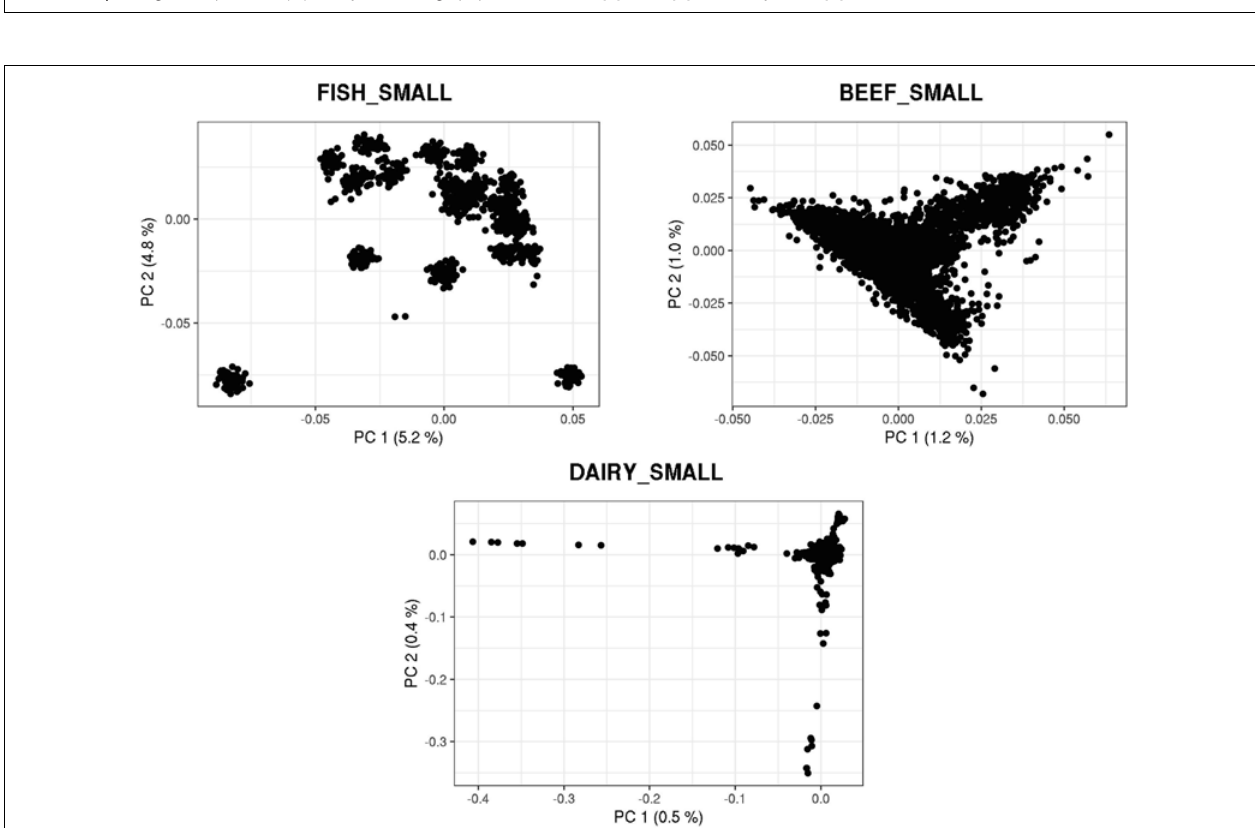
FIGURE 3 | First and second principal components of the genomic relationship matrices for the small populations of fish, beef, and dairy cattle.